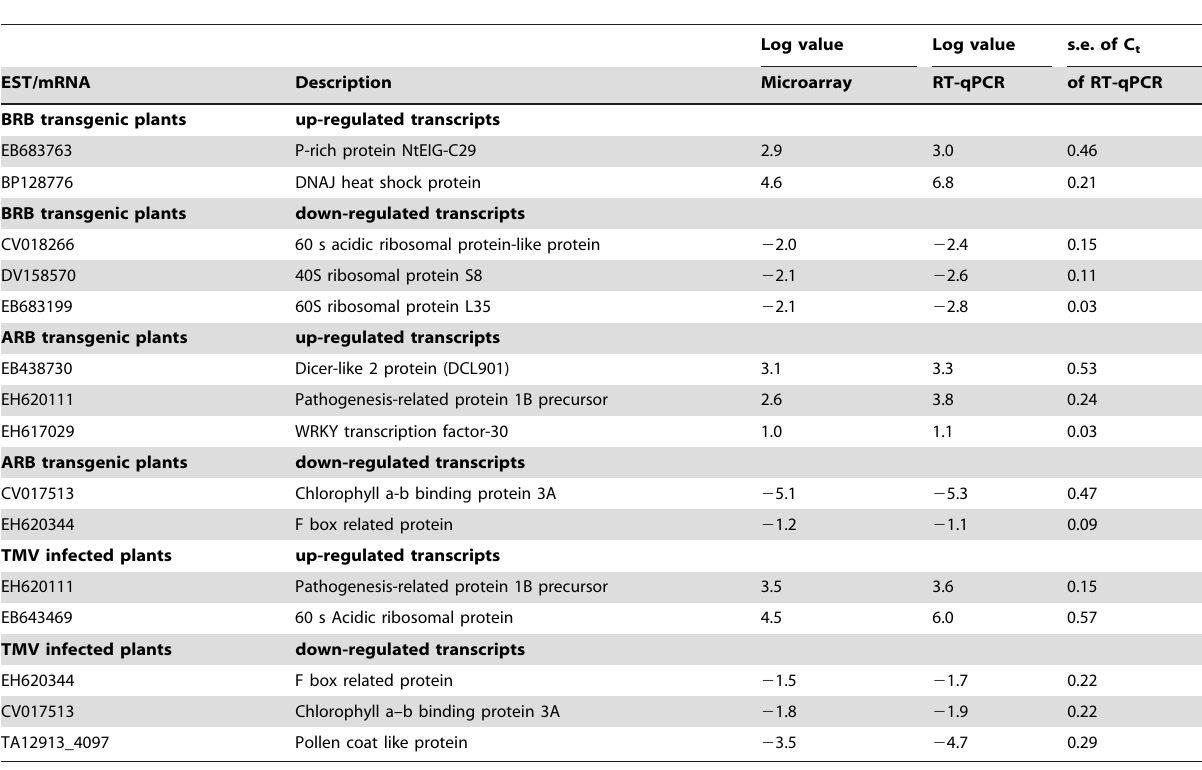
Table 1. Microarray results verification by using quantitative real-time PCR